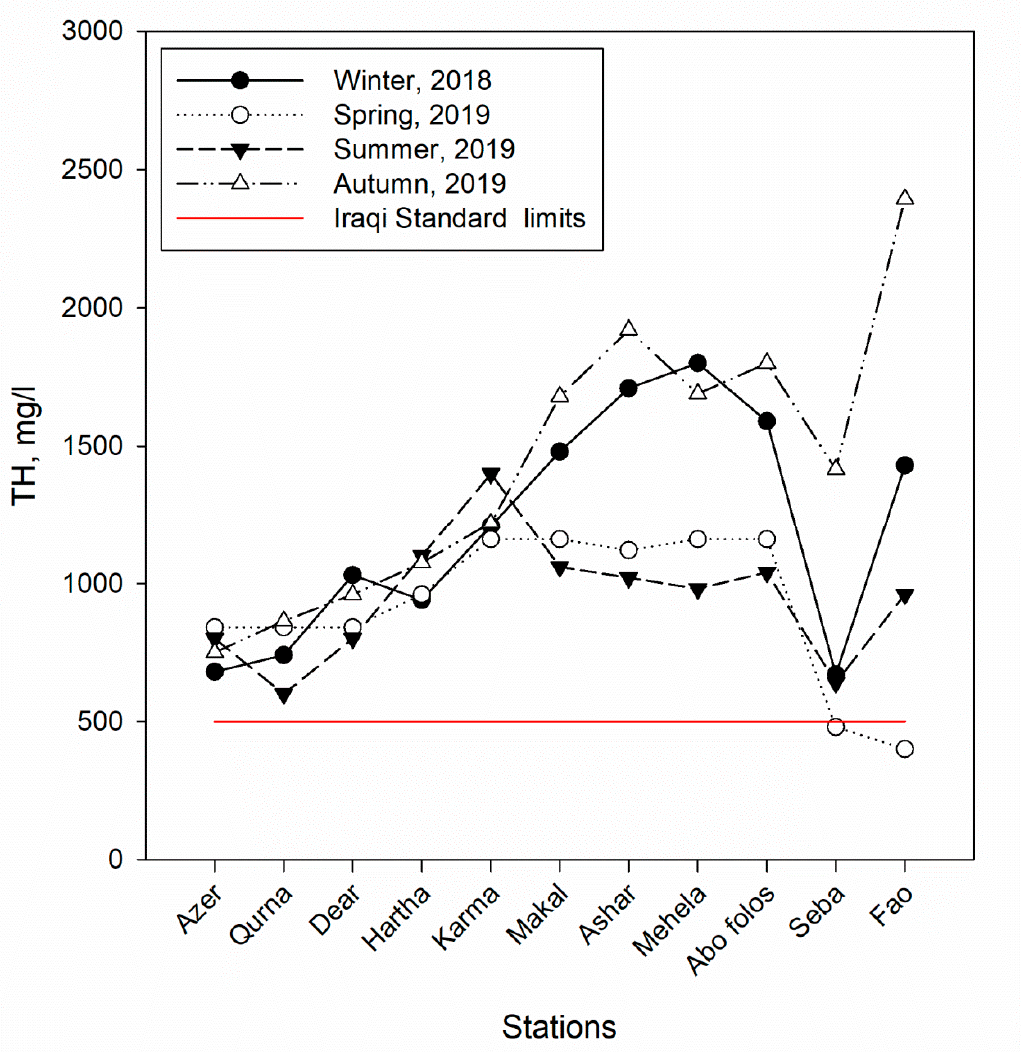
Figure 10. Total hardness concentrations of the selected stations for different seasons during the study period.